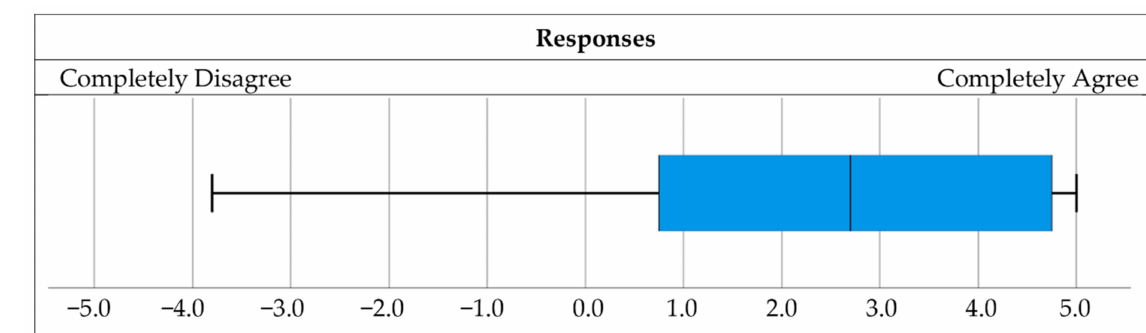
Figure 9. Opportunities regarding introduction of UAVs.